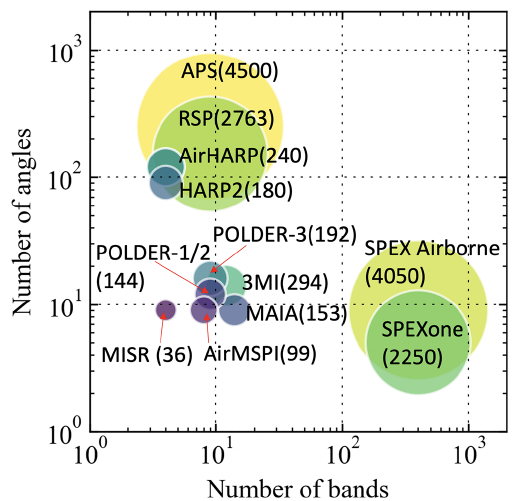
Figure 1. Current MAPs in terms of the number of spectral bands and total number of viewing angles as summarized in Gao et al. (2021b). The bubble size for each instrument corresponds to the total number of measurements as indicated next to the instrument name. The full name and reference of the instruments are provided in Table 1. POLDER-1, 2, and 3 refer to the instruments on the ADEOS-I, ADEOS-II, and PARASOL missions. Note that MISR conducts multi-angle measurements without considering polariza-